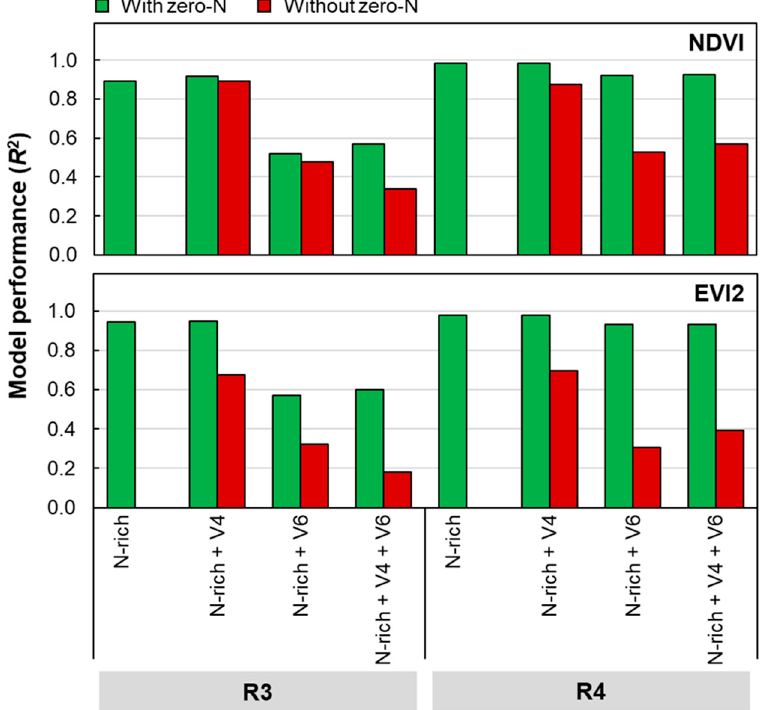
Figure 7. Corn yield estimation model performance using NDVI and EVI2 as inputs and selected sidedress treatment combinations, with and without zero-N treatment (33 kg N ha − 1 starter N only, no sidedress N application) included at R3 and R4.